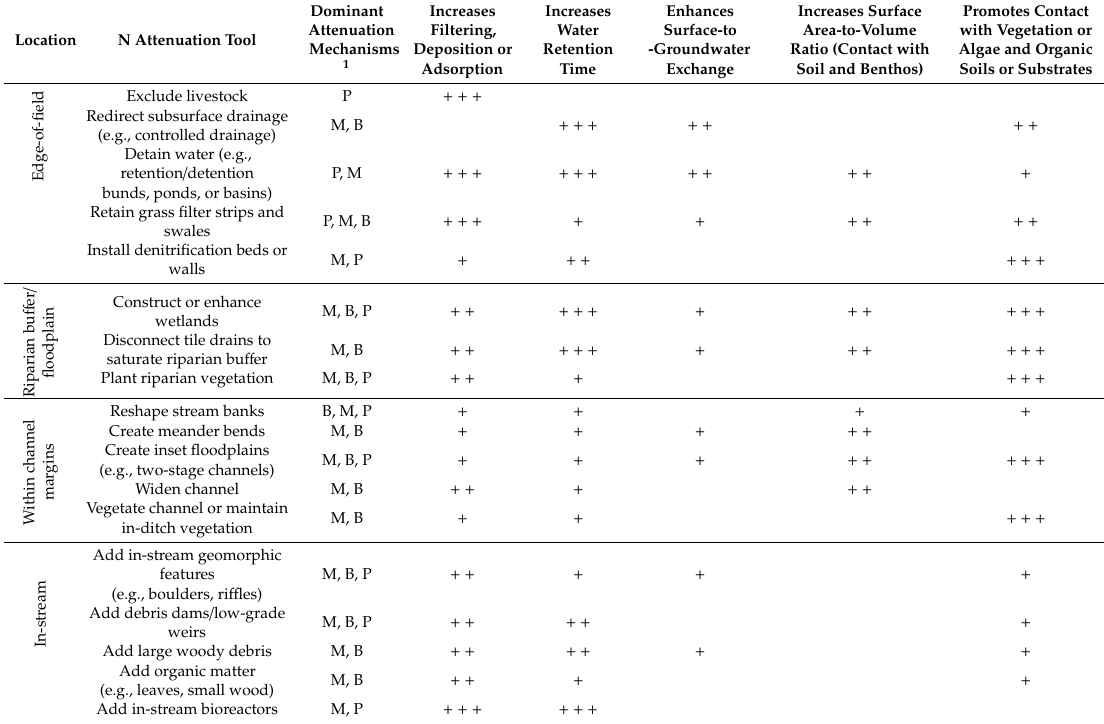
Table 2. Examples of how N attenuation tools can enhance multiple physical and biogeochemical attenuation processes. Tools are grouped by their location from the edge-of-field to in-stream. The attenuation mechanisms and criteria supported by tools were adopted from [24,115,118]. The degree to which tools boost these criteria is indicated as follows: + conditional / sometimes, ++ always, +++